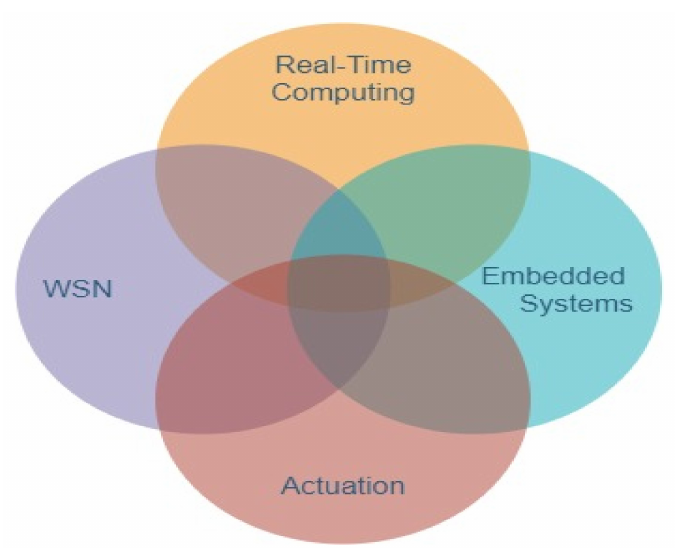
Figure 1. IoT is the union of several